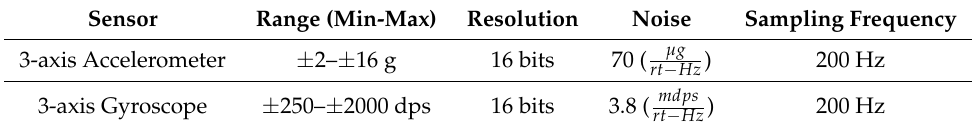
Table 3. Smartphone embedded inertial sensors